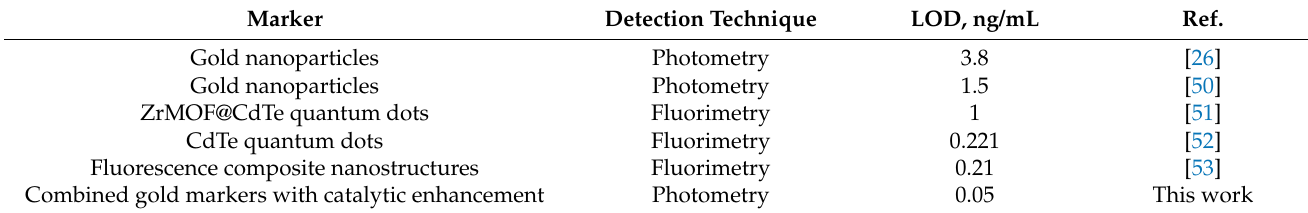
Table 3. Comparative